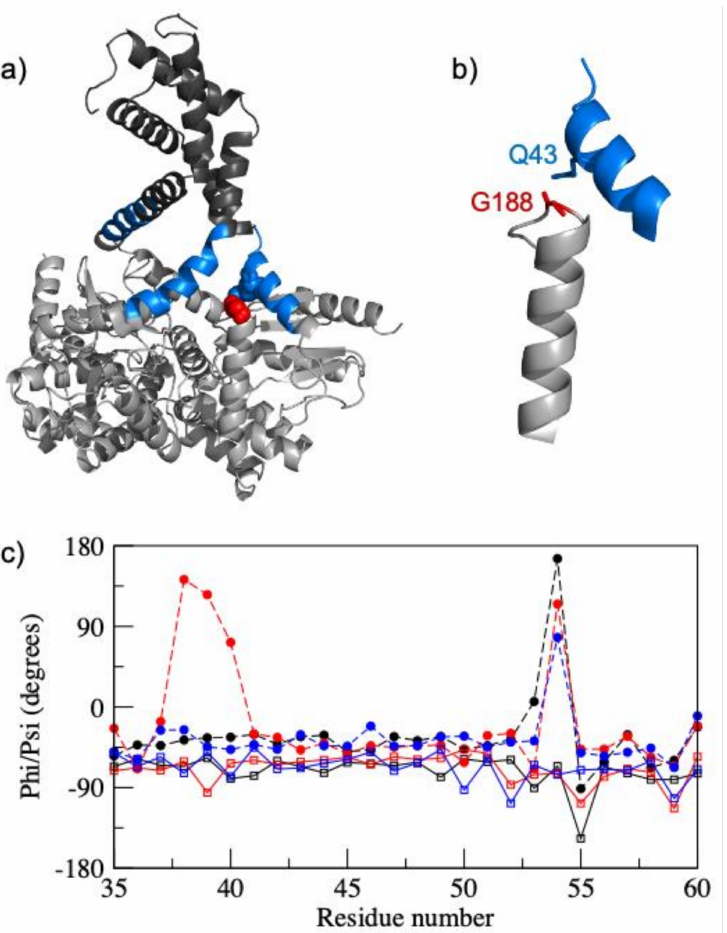
Figure 4. Structural changes observed in a 20 ns molecular dynamics simulation of the extended structure trimer of PmScsC. ( a ) Cartoon representation of the trimer after 20 ns MD simulation. The linker peptide is shown in blue in all three molecules. Gln 43 and Gly 188 from molecule B are shown in blue and red, respectively. ( b ) An expansion showing residues 38–50 and 174–193 from molecule B. Following partial unfolding of the helical linker peptide, the side chain N ε 2 of Gln 43 and the backbone CO of Gly 188 form a hydrogen bond which is not found in the starting structure. ( c ) Phi (open square and solid line) and psi (filled circle and dotted line) torsion angles for residues 35–60 in chains A (black), B (red) and C (blue) in the trimer at the end of the 20 ns MD simulation. Residues 38 and 39 adopt extended β -strand phi/psi angles in chain B after the 20 ns